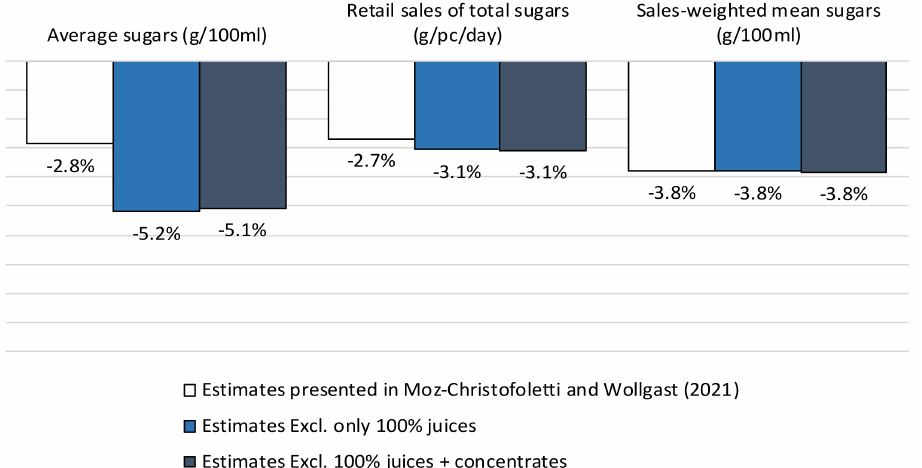
Figure 1. Evolution of the average sugars (g/100 mL), retail sales of total sugars (g/pc/day) and sales-weighted mean sugars (g/100 mL) in different categories of soft drinks between 2015 and 2018 in 22 European countries. Source: Elaborated by the authors based on data from [5]. Note: The values were scaled by the market coverage to represent 100% of the retail market. (1) As defined by Euromonitor, the category Soft Drinks covers Asian Speciality Drinks, Carbonated RTD Tea, Coconut and Other Plant Waters, Flavoured Bottled Water, Functional Bottled Water, Ginger Ale, Juice Drinks (up to 24% Juice), Lemonade/Lime, Liquid Concentrates, Low Calorie Cola Carbonates, Nectars, Not from Concentrate 100% Juice, Orange Carbonates, Other Non-Cola Carbonates, RTD Coffee, Reconstituted 100% Juice, Regular Cola Carbonates, Regular Energy Drinks, Regular Sports Drinks, Still RTD Tea and Tonic Water/Other Bitters. (2) EU19 plus Norway, Switzerland and the United